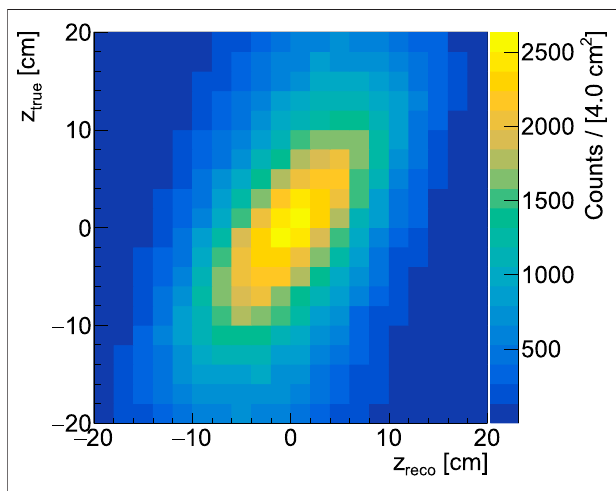
FIGURE 11 | Unfolding matrix computed from a FLAT sim (extended photon source within a PMMA target). Z reco is the photon coordinate reconstructed by the PAPRICA detector having the same geometry of the FULL sim, while Z true is its generation coordinate.